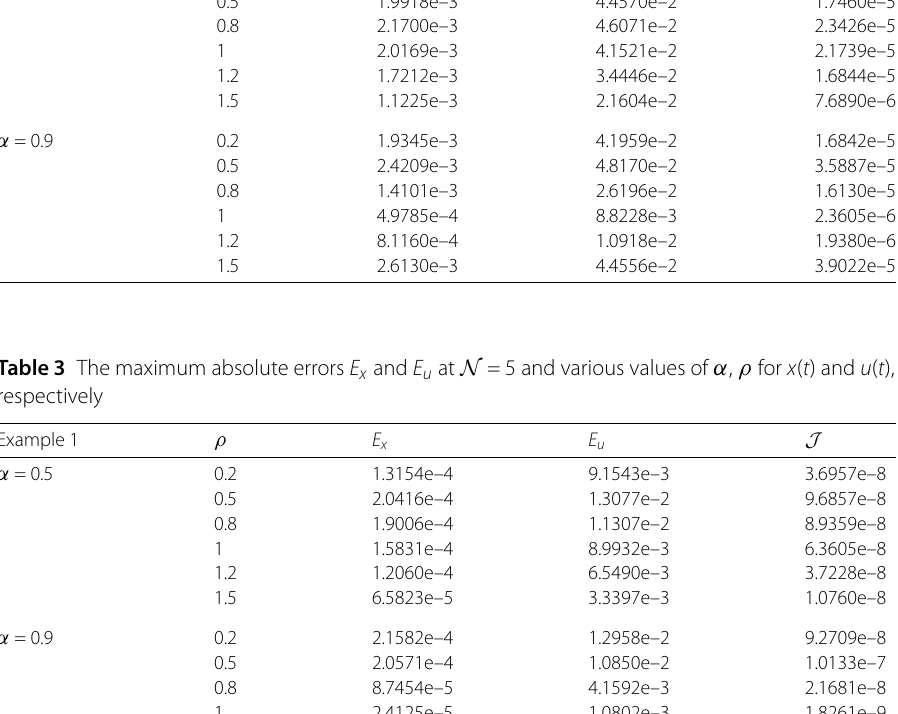
Table 2 The maximum absolute errors E x and E u at N = 3 and various values of α , ρ for x ( t ) and u ( t ), respectively Example 1 ρ E x E u J α = 0.5 0.2